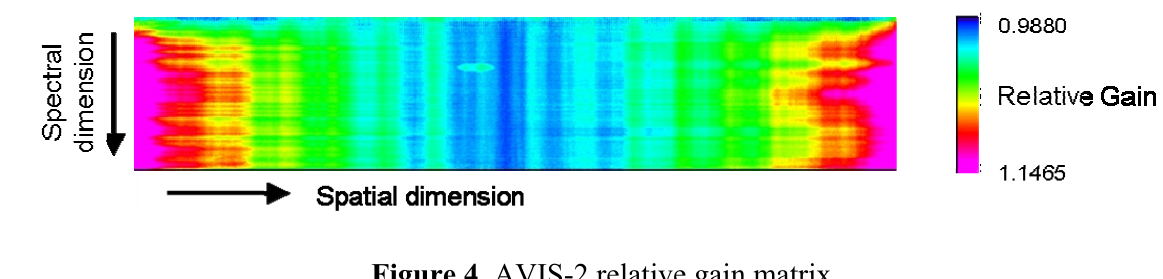
Figure 4. AVIS-2 relative gain